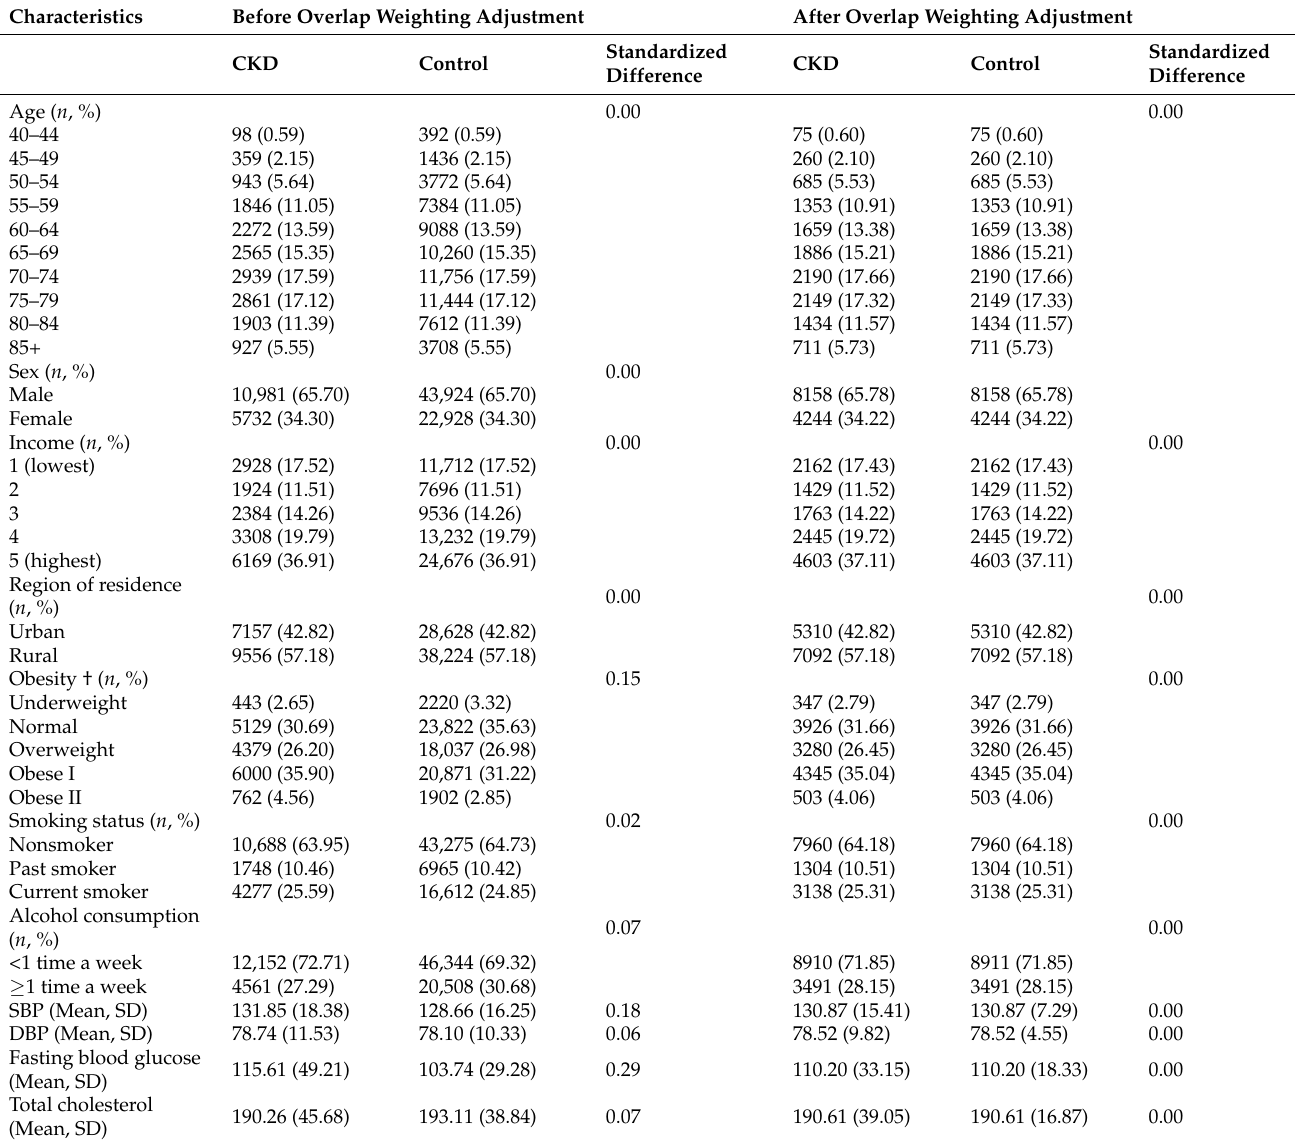
Table 1. General Characteristics of